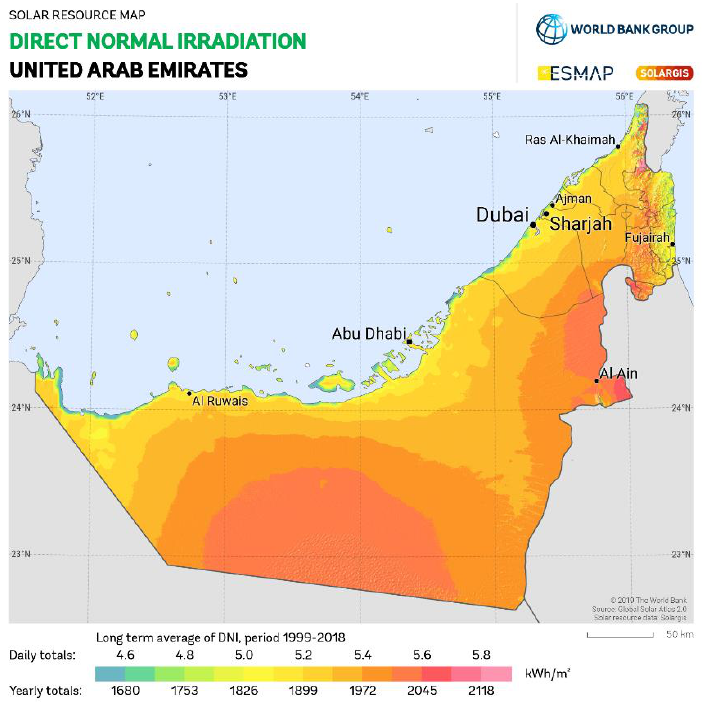
Figure 1. PV solar power generation potential map of the UAE [11].